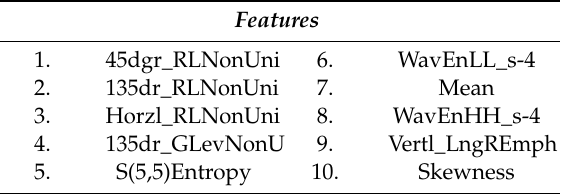
Table 1. Optimized fused hybrid-feature selection table (POE + AC).